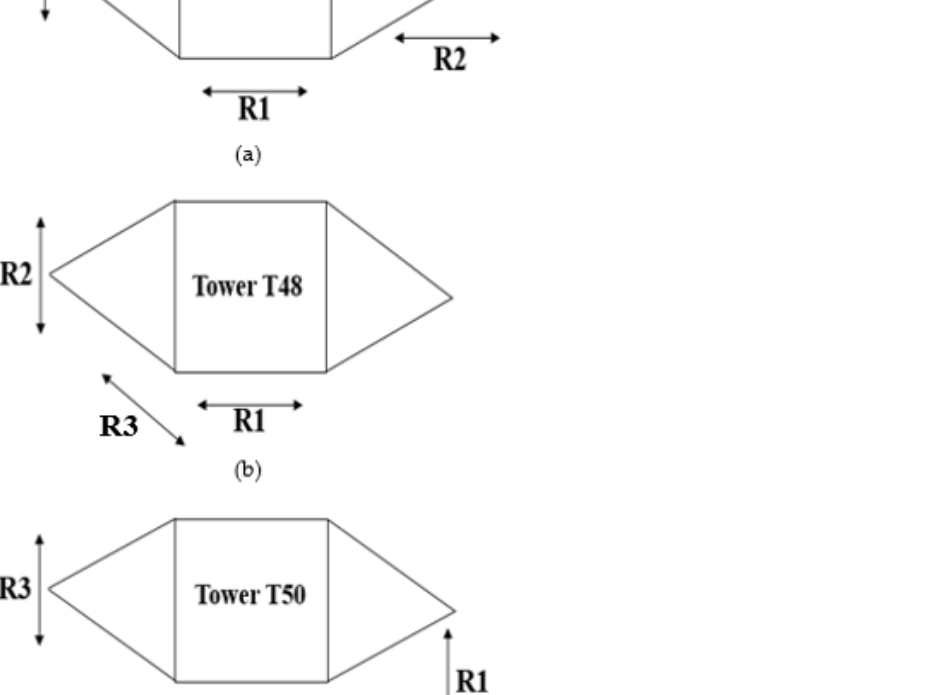
Table 2. Averages of apparent resistance (Ω) value s.